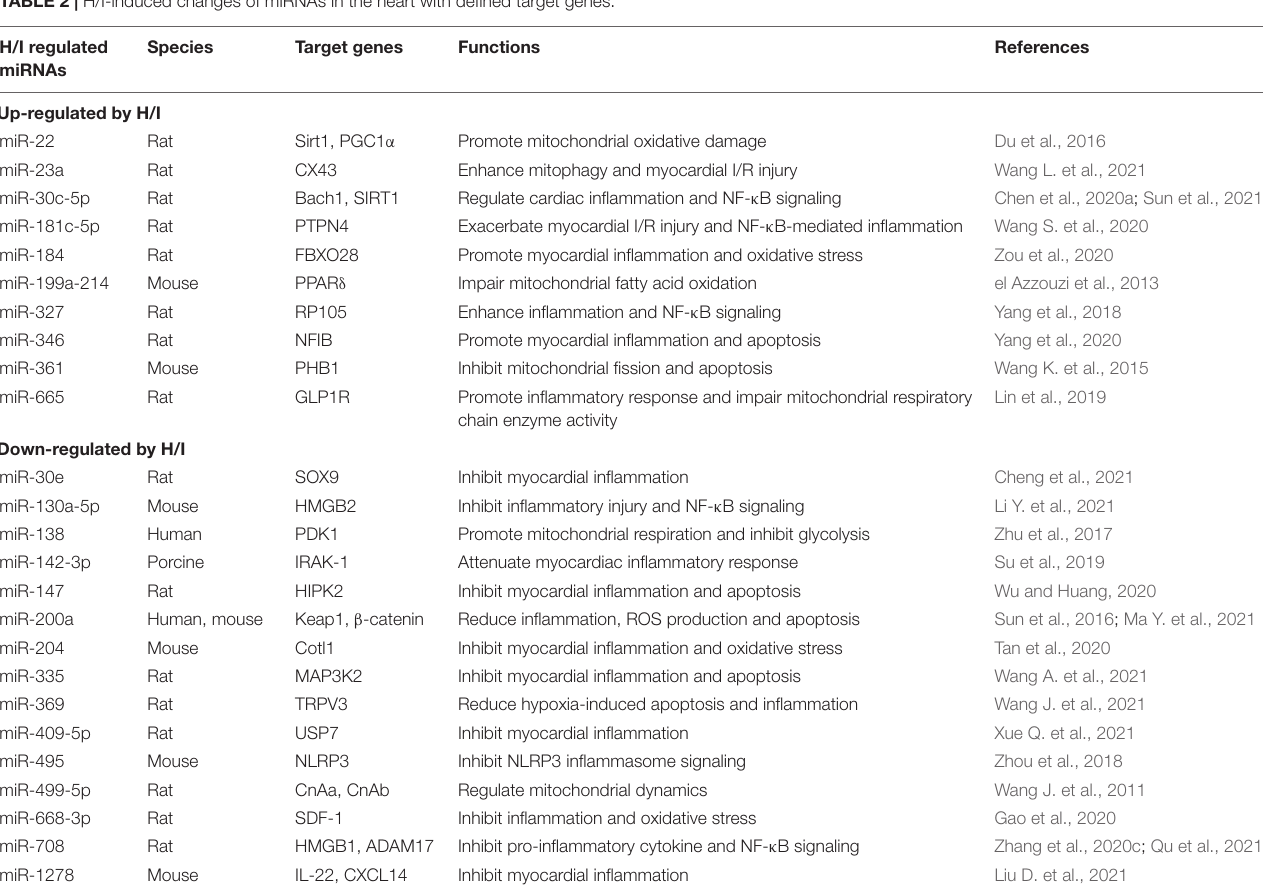
TABLE 2 | H/I-induced changes of miRNAs in the heart with defined target